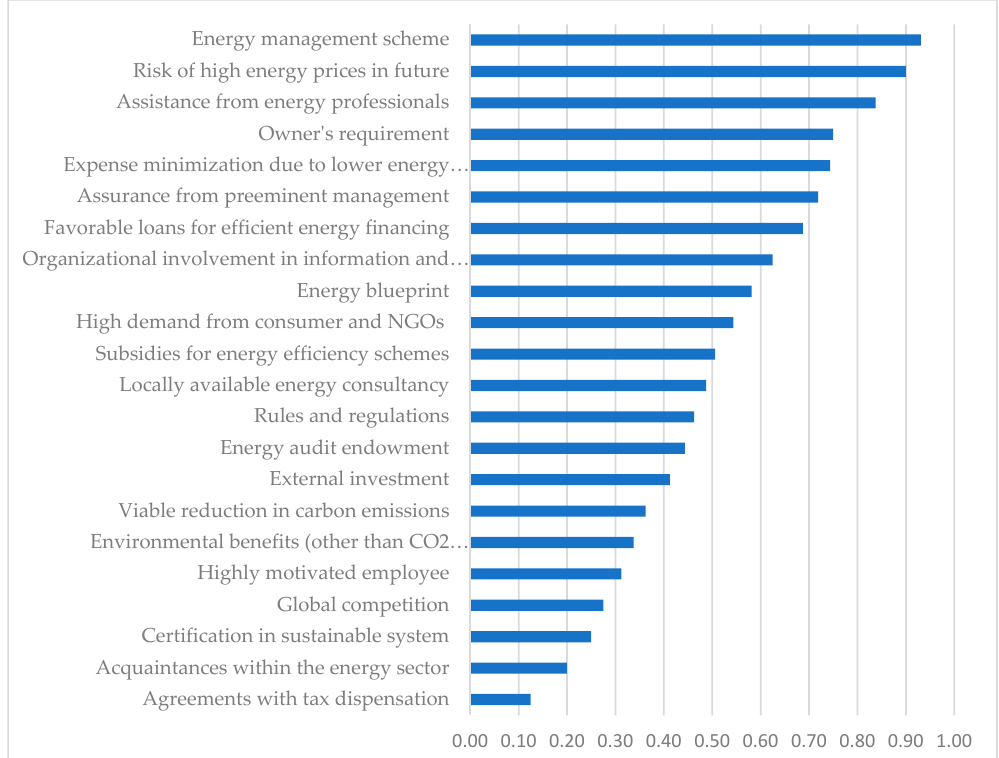
Figure 7. The perceived drivers to energy efficiency in the textile industries of Bangladesh.